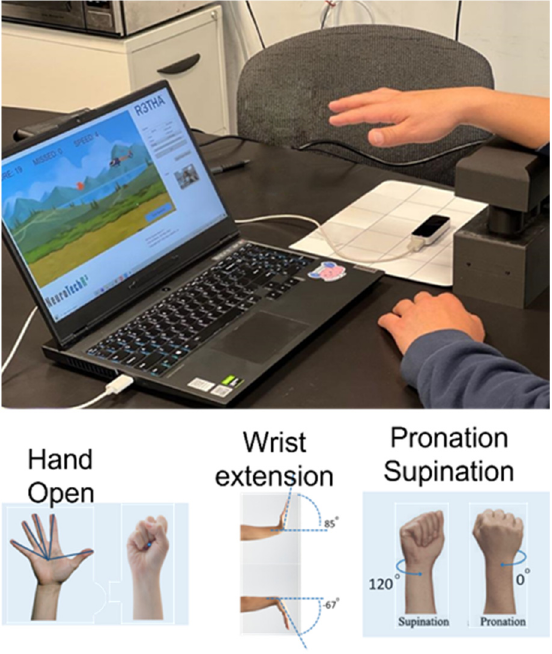
Figure 2. Orientation of camera and measurements ( Top ) Experimental set up; ( Bottom ) Movements measured by LMC.